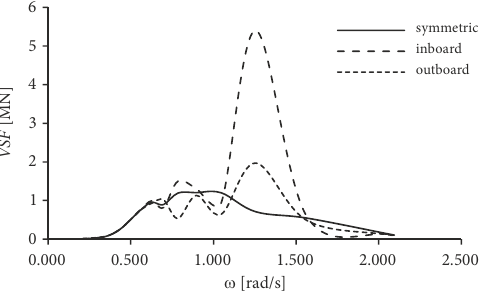
Figure 7. RAOs of vertical bending moments VBM in head seas